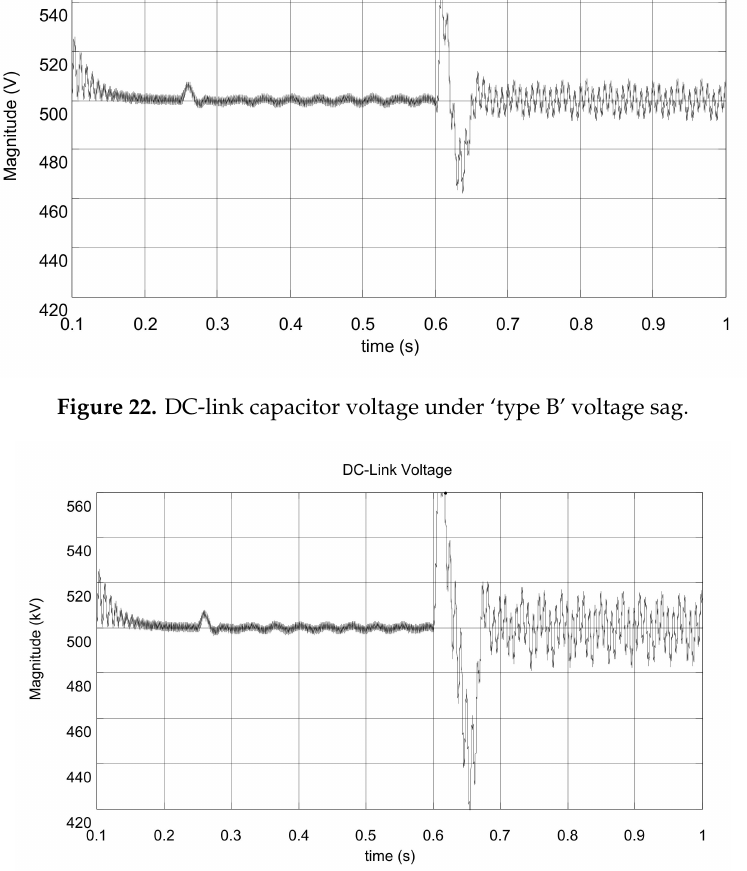
Figure 23. DC-link capacitor voltage under ‘type C’ voltage